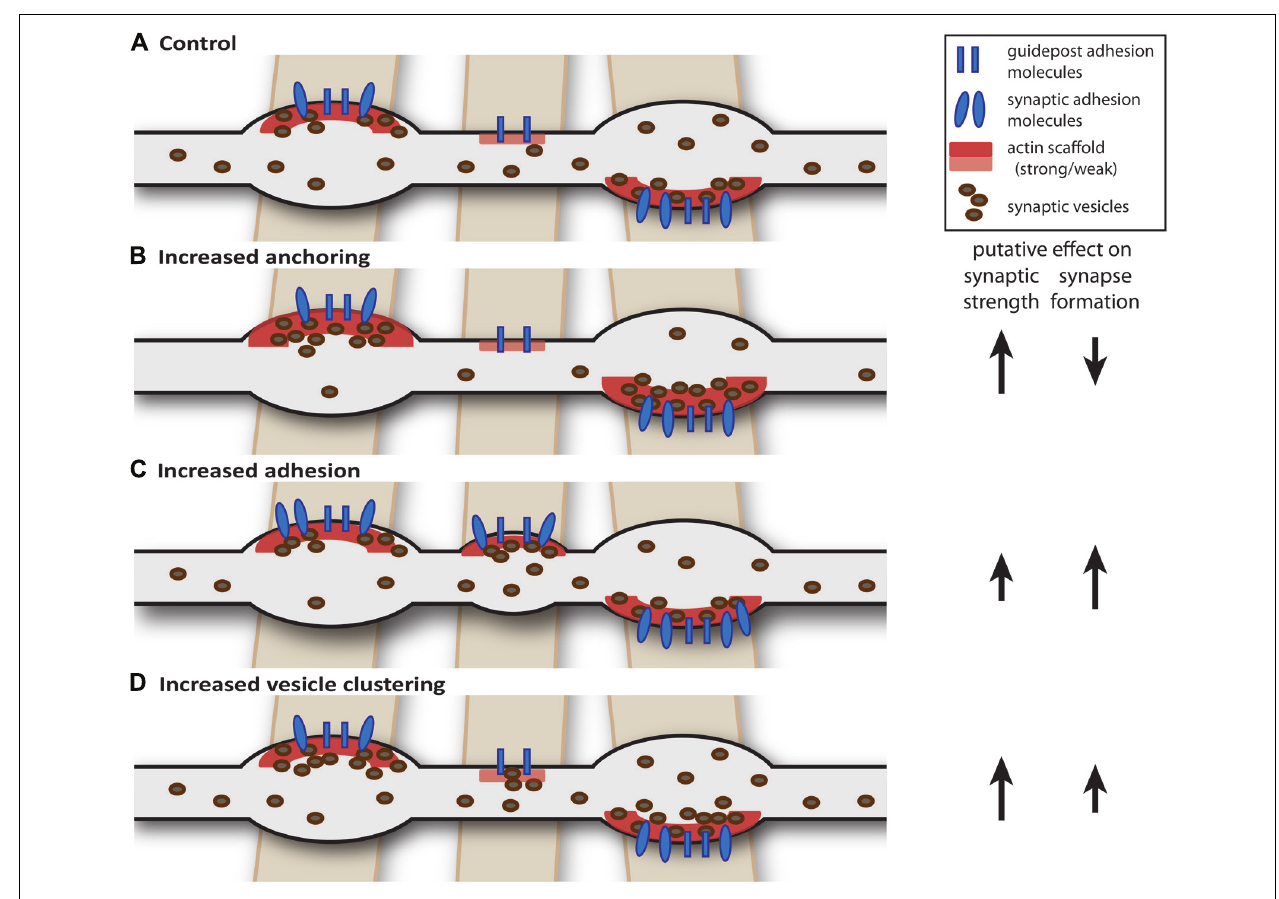
of “free” vesicles, thereby reducing the probability of forming new synapses (Yamada etal., 2013). (C) Increasing synaptic adhesion increases the number of synapses (Scheiffele etal., 2000; Takahashi etal., 2012; Kuzirian etal., 2013) and may also affect properties of existing synapses (Varoqueaux etal., 2006; Wittenmayer etal., 2009). (D) Overexpression of vesicle clustering factors induce changes in release properties, but may also promote synapse formation (Wentzel etal., 2013; Wu etal.,